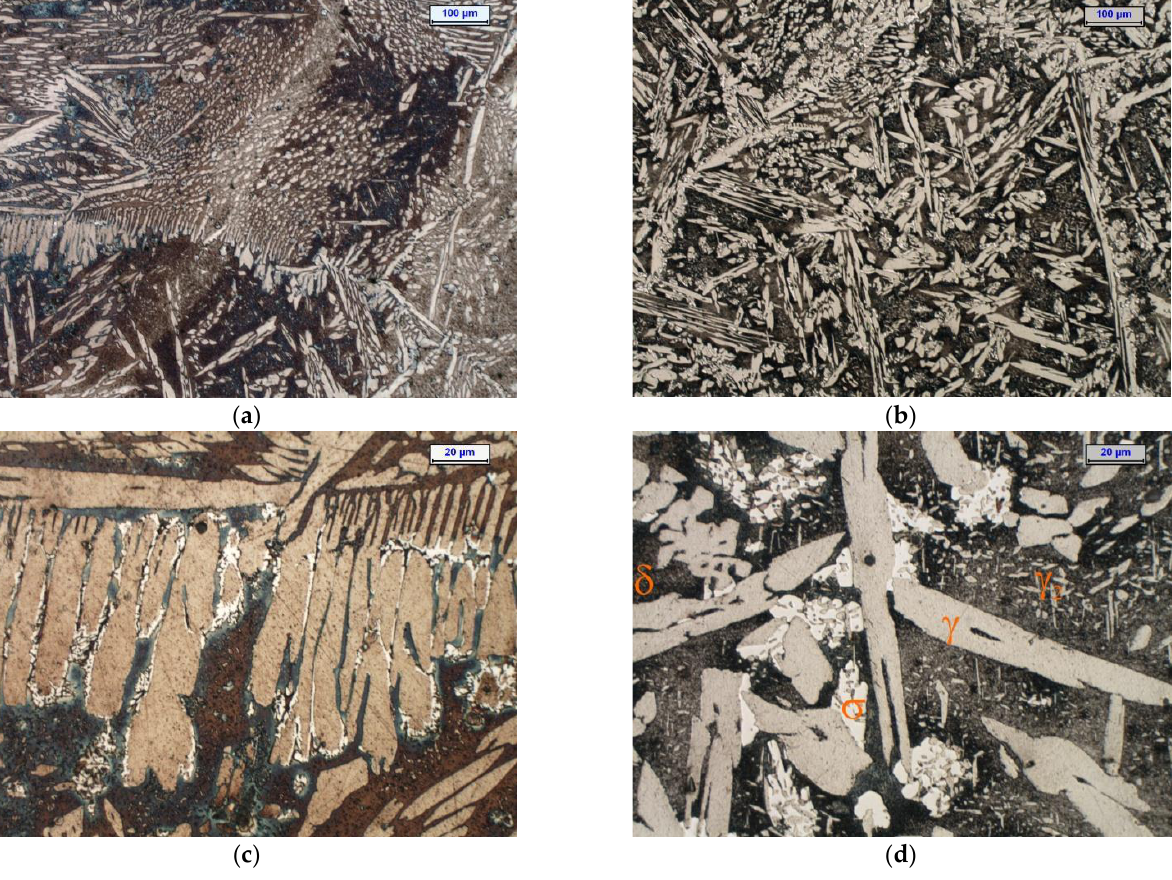
Figure 3. Microstructure of tested cast steel after isothermal holding for 3 h at 750 ° C ( a , c ) and 900 ° C ( b , d ) —light microscope, etching with Beraha’s reagent (dark— ferrite; beige — austenite; white — σ phase and carbides); ( a , b ) — 100× magnification and ( c , d ) — 500× magnification.